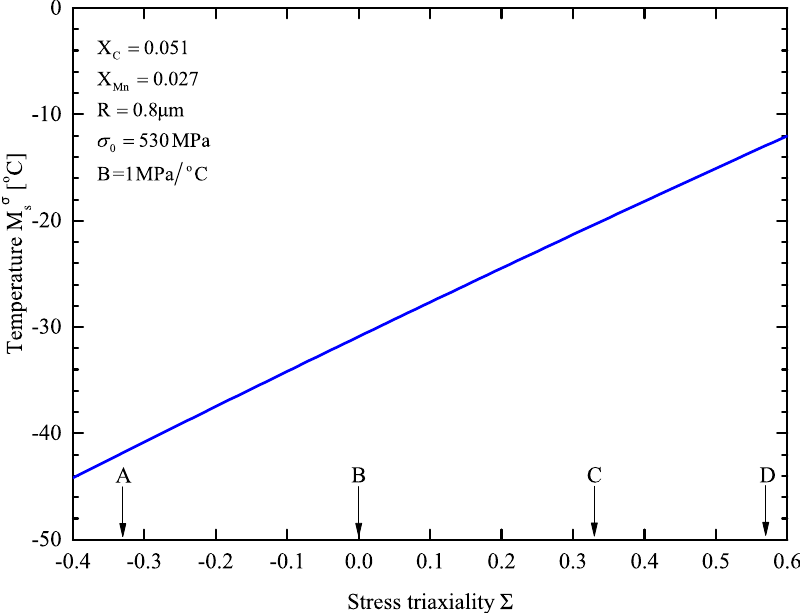
Figure 9. M σ s temperature as a function of stress triaxiality ( Σ = p / σ e ) in retained austenite. (A): Uniaxial compression ( Σ = − 1/3 ) , (B): Pure shear ( Σ = 0 ) , (C): Uniaxial tension ( Σ = 1/3 ) , √ (D): Plane strain tension ( Σ = 1/ 3 = 0.577 )